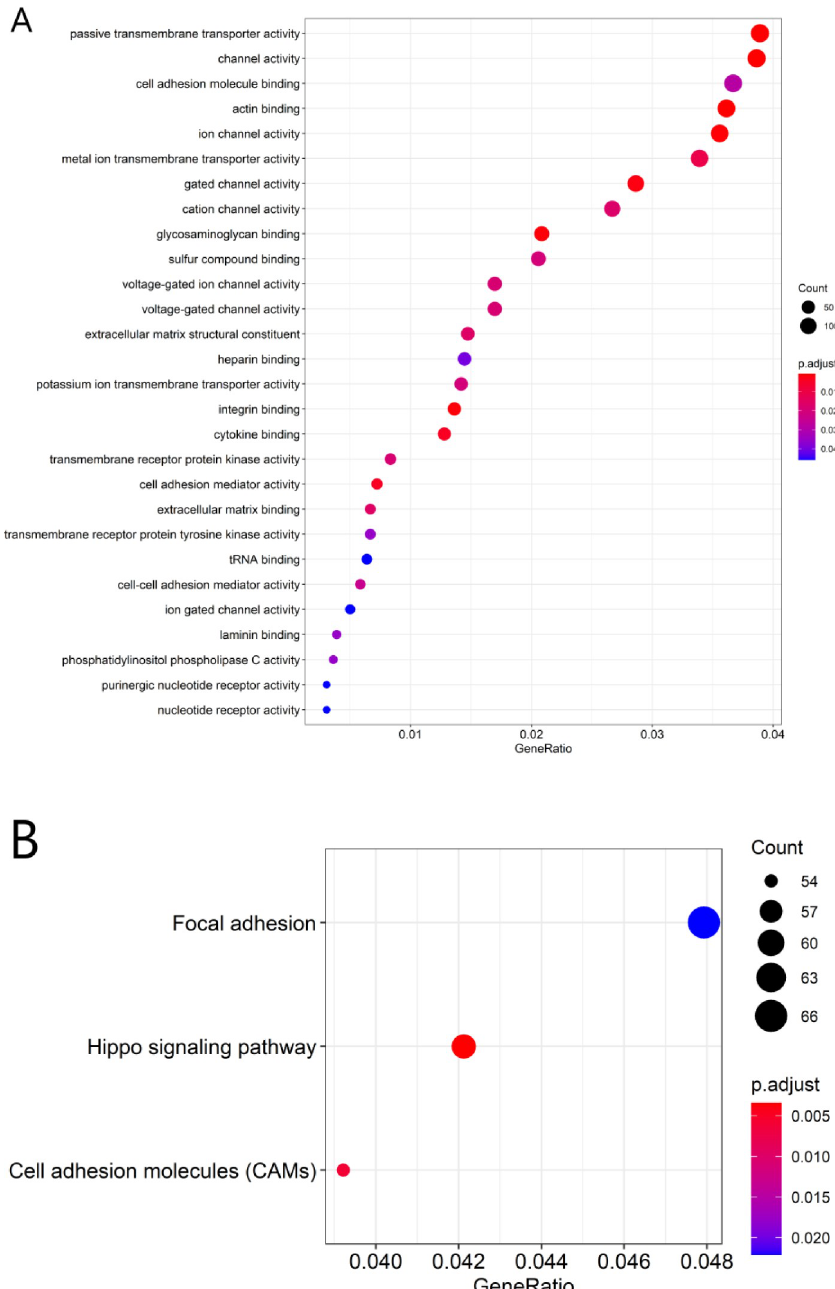
Fig 16. Functional enrichment analysis for the related biological processes and pathways related to the 4 lncRNAs used in that model. GO biological process enrichment results (A). KEGG signaling pathways analysis (B).